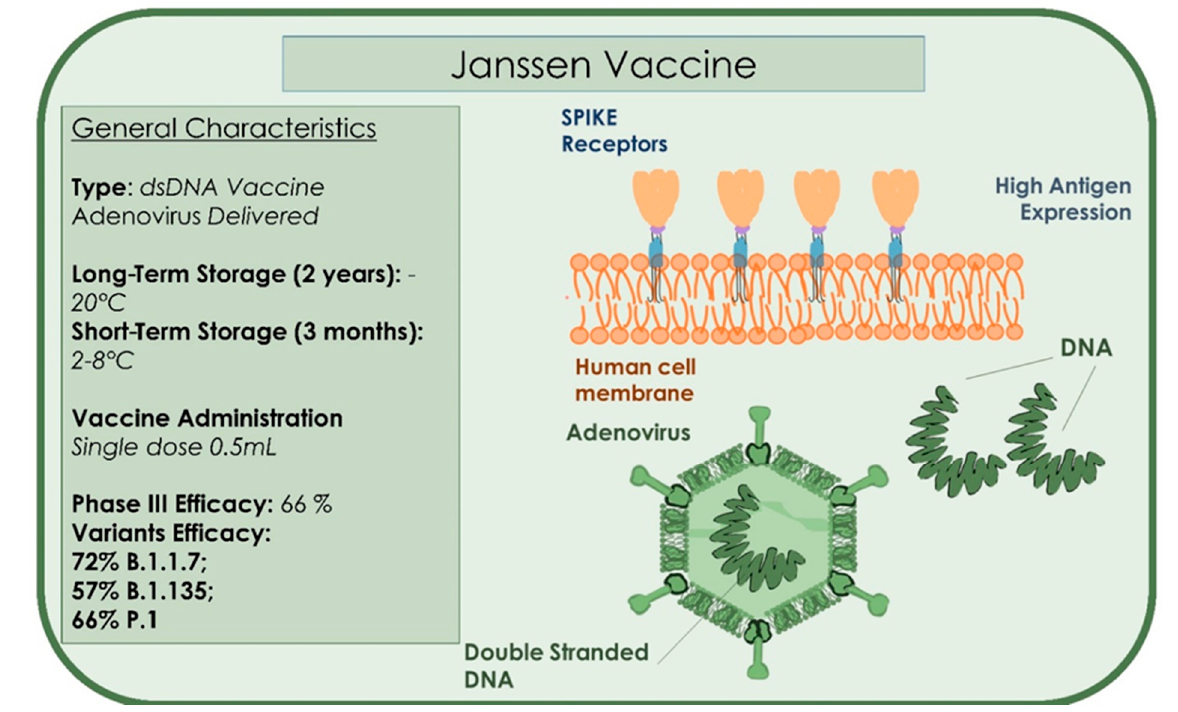
Figure 8. Summary of the type, storage administration, and efficacy characteristics of the Janssen vaccine.